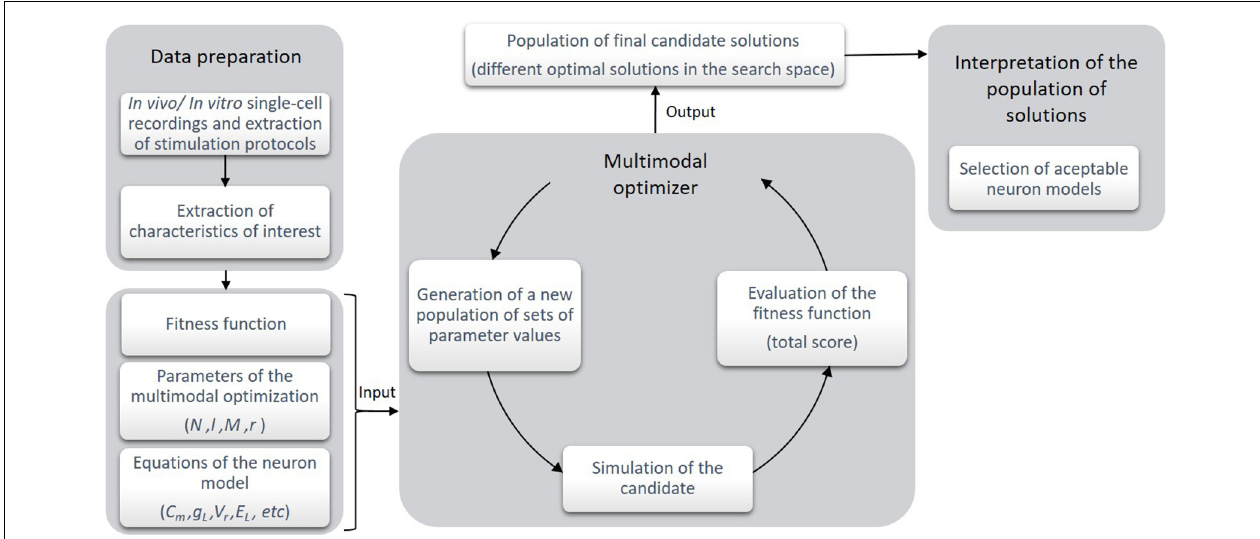
FIGURE 1 | Stages of the optimization framework. At the first stage, the experimental recordings of the biological cells are obtained and the characteristics of interest are selected and calculated. Then, according to these data, a fitness (or objective) function is built and the parameters of the algorithm and the neuron model are selected. At the second stage, the execution of the multimodal optimizer takes place. The optimization process consists in generating a number of candidates (i.e., sets of parameter values) which are simulated and evaluated according to the objective function. Finally, as the output of this stage, a population of different candidate solutions is returned in a single execution of the algorithm. These selected candidates are illustrative of some local optima in the search space of the objective function. At this point, the expert interprets if the candidate solutions are as numerically valid as their scores estimate. Quantitatively and qualitatively, the best-ranked candidate solutions are selected as the neuron models